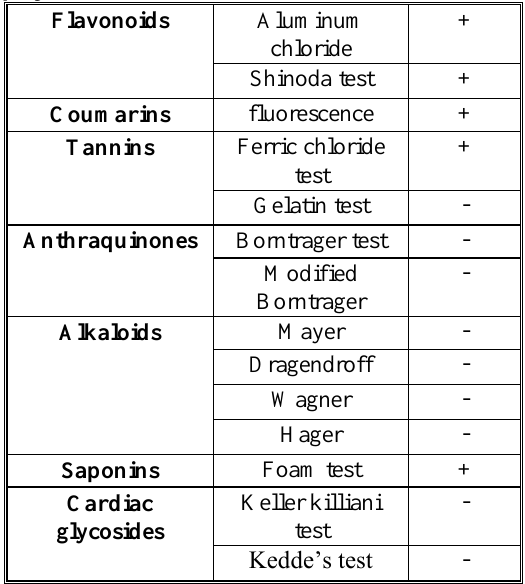
polyceras roots